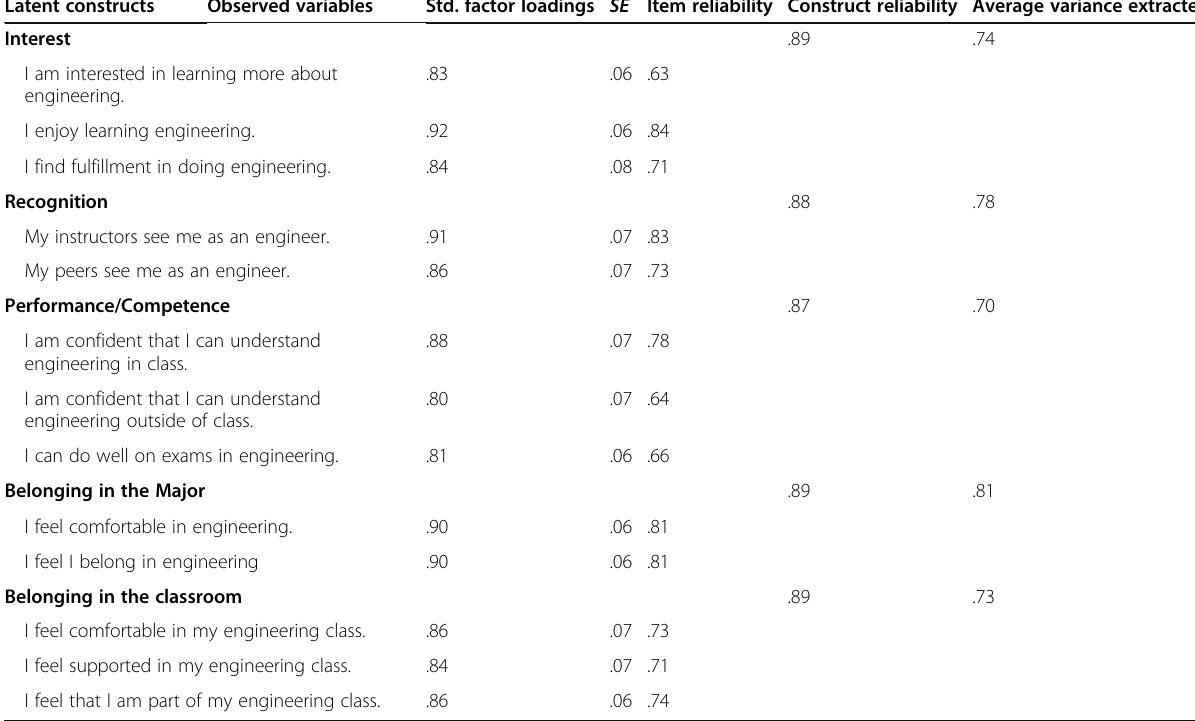
Table 2 Summary of measurement model estimates and factor reliabilities for all women Latent constructs Observed variables